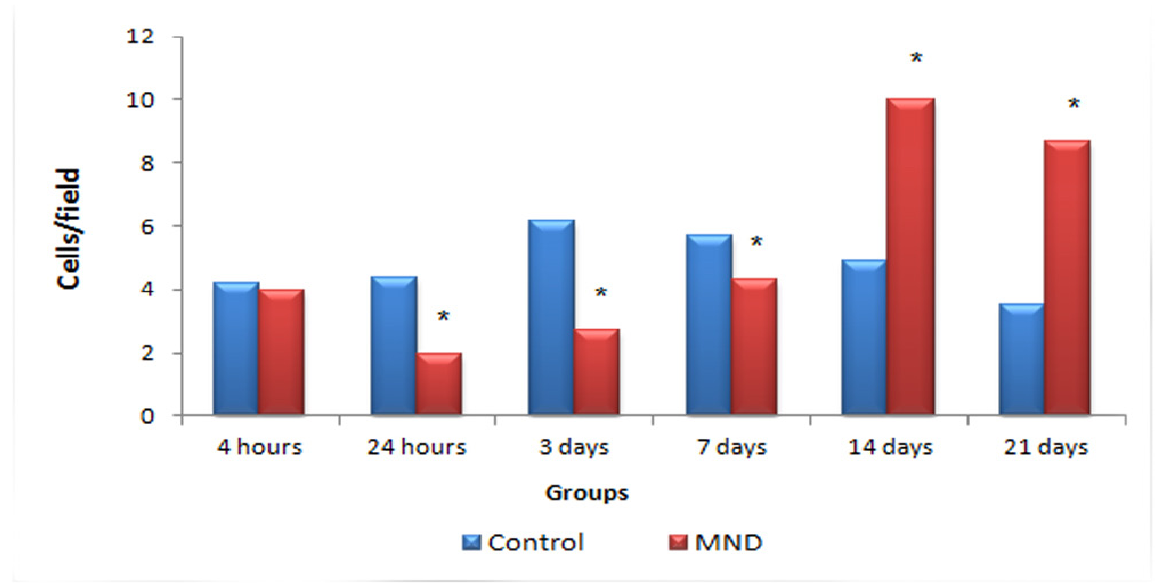
Figure 4. Determination of the number of mast cells in the skin of mice after injection of Bothrops cotiara venom (100 µg/50 µL) or 0.9% NaCl solution (control group). Cell count was made on toluidin blue-stained section. Four random fields from four different areas of the skin were analyzed in a magnitude of 400x, totaling 16 fields per animal. To obtain the values on the chart, the number of cells found in control groups for each time was subtracted from the total cells found in the sections from experimental groups of the same treatment time. *Statistical significance when compared with control group for p < 0.05. MND: minimum necrotizing